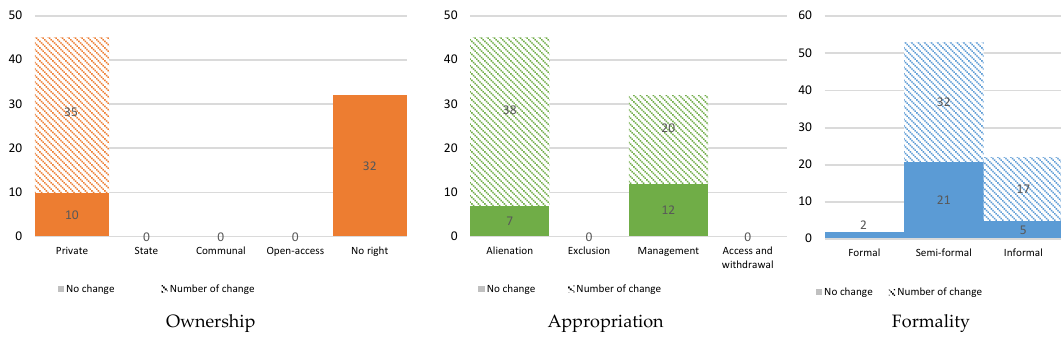
Figure 12. The number of property rights transformation on residential lands in MTB.